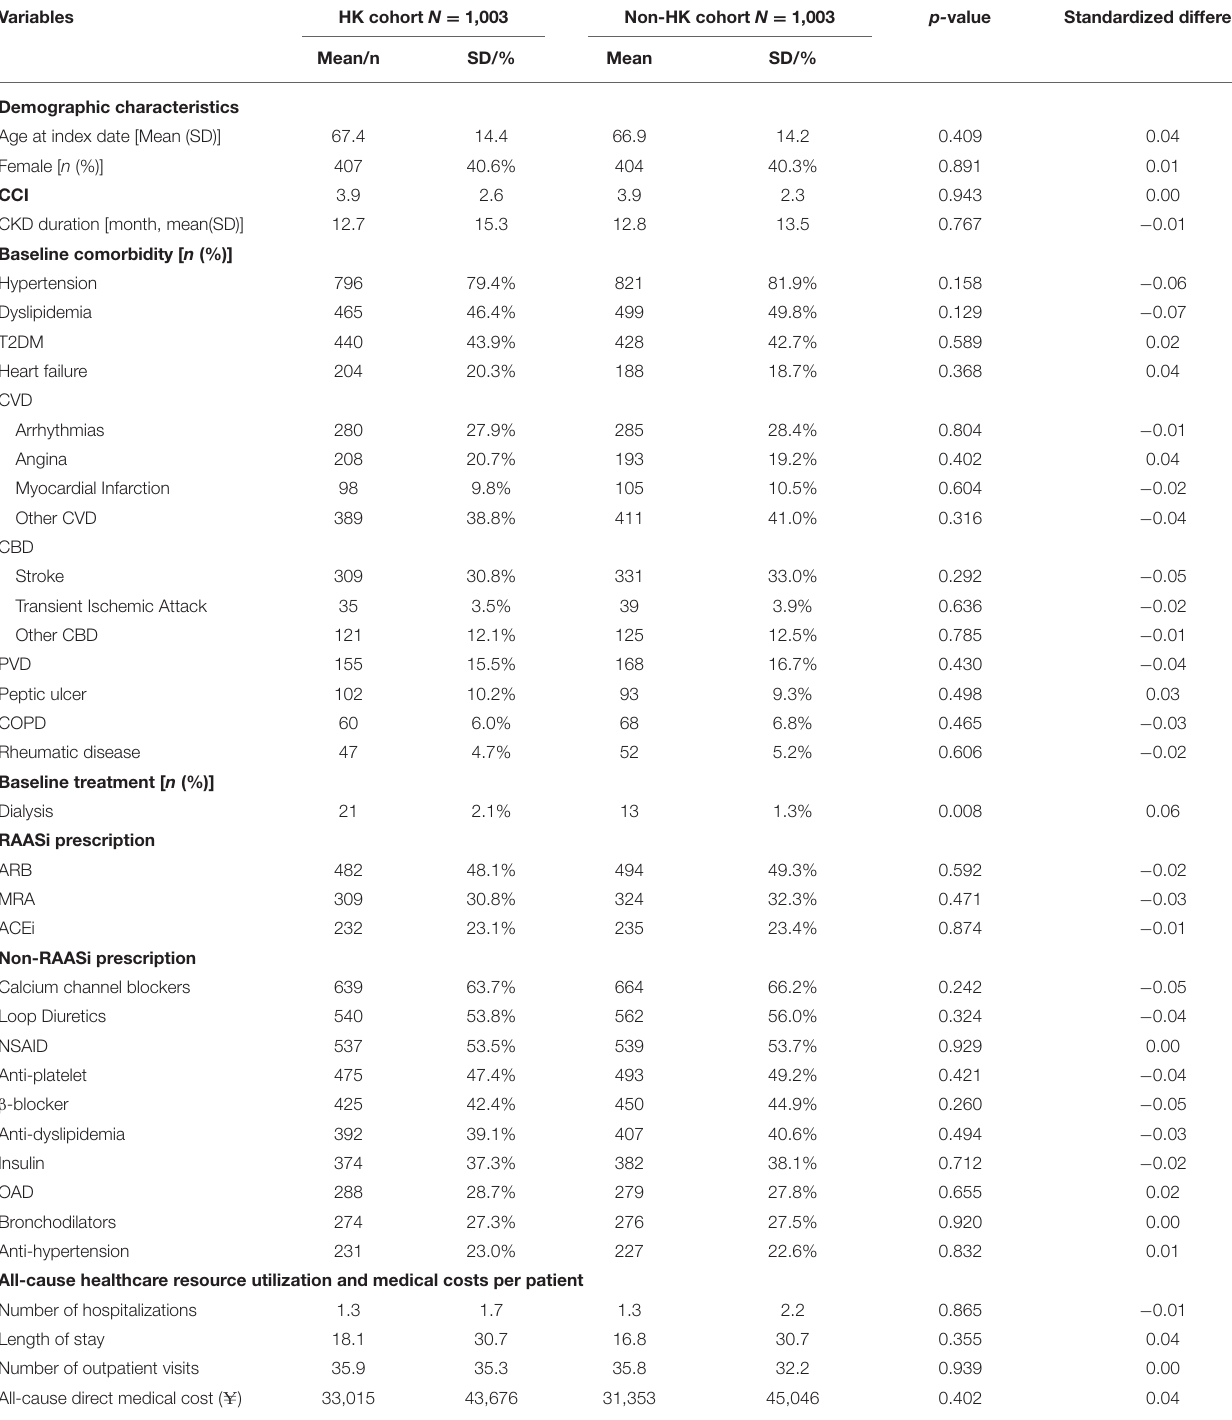
TABLE 1 | Baseline characteristics of the HK and non-HK cohorts after propensity score matching. Variables HK cohort N = 1,003 Non-HK cohort N = 1,003 p- value Standardized difference